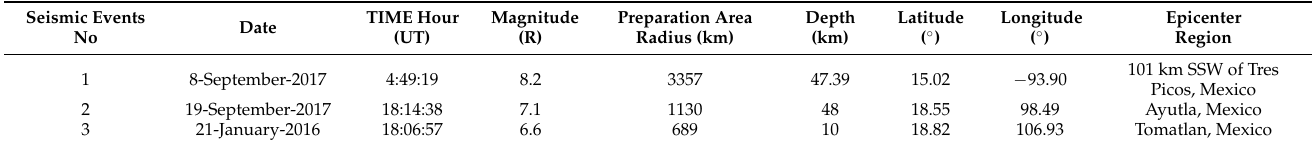
Table 1. List of selected seismic events and their